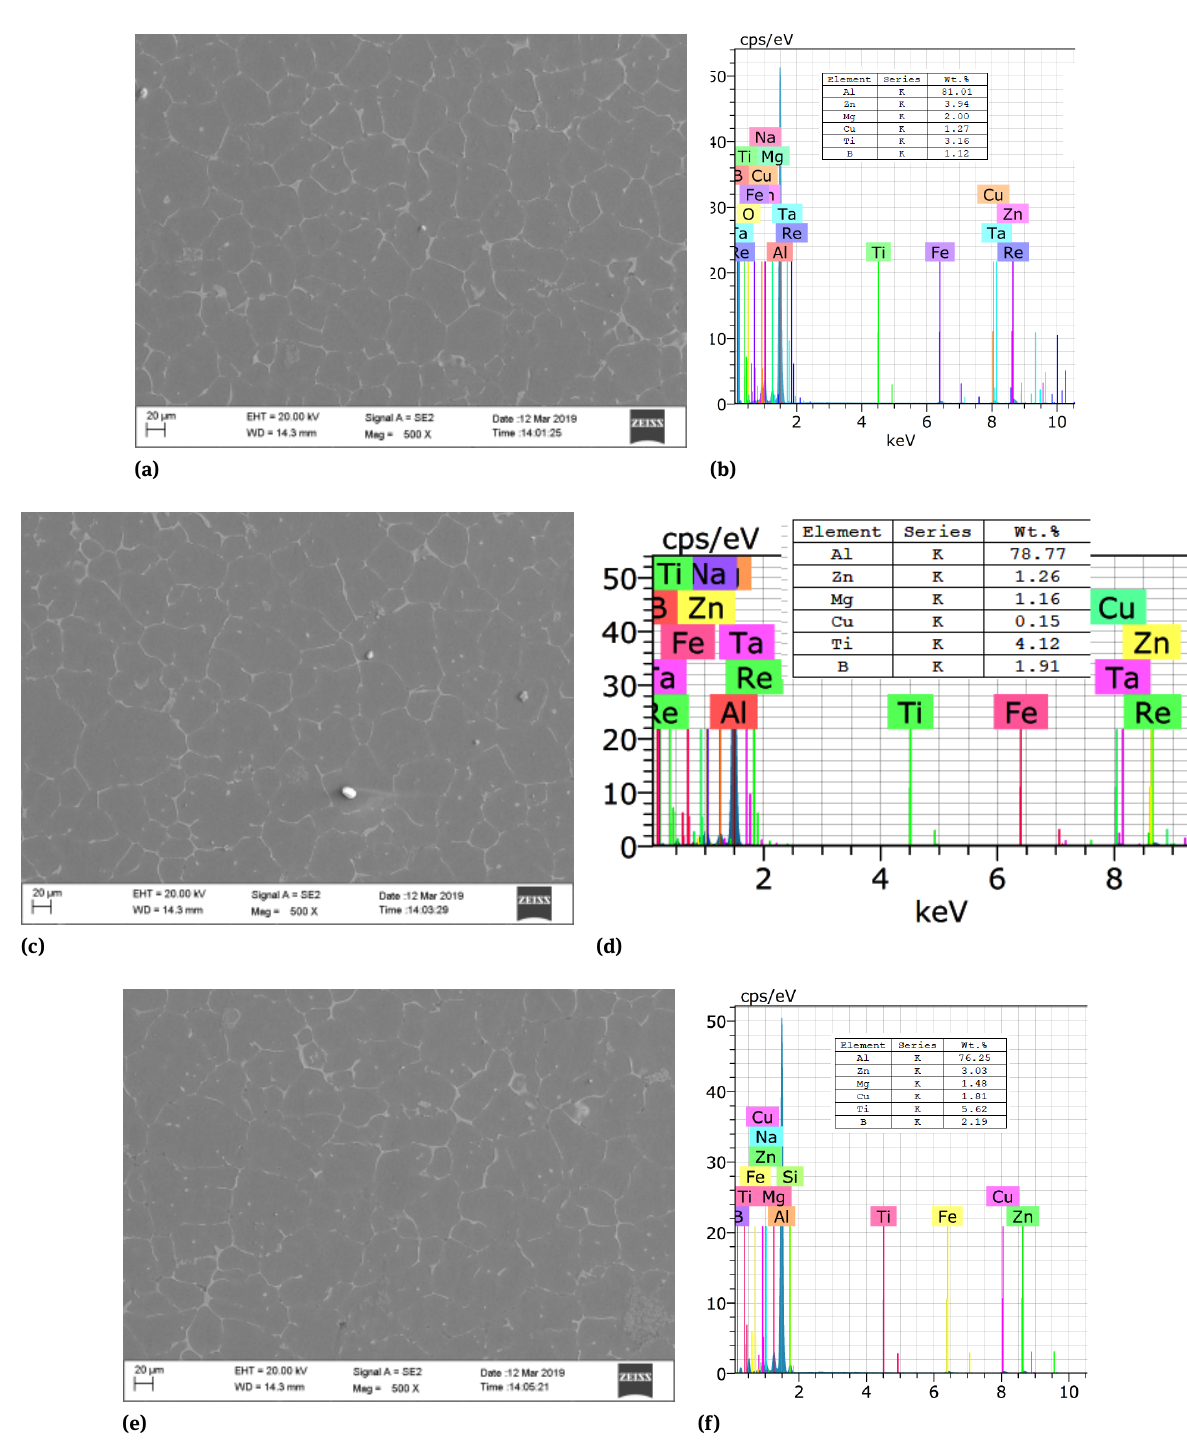
Figure 3: FESEM and EDS of AA7010-TiB 2 composites (a) & (b) 5% TiB 2 , (c) & (d) 7.5% TiB 2 and (e) & (f) 10% TiB